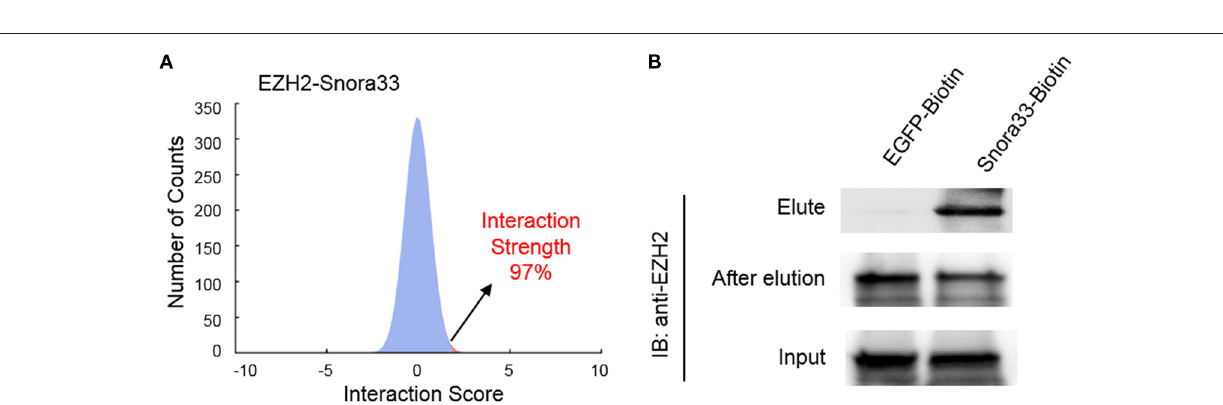
FIGURE 5 | Validation of the interaction between EZH2 and Snora33. (A) Predicted interaction strength between EZH2 and Snora33 using catRAPID. Among a thousand of random RNA sequences, Snora33 ranked 97% propensity to interact with EZH2. (B) RNA pull-down analysis to confirm the direct interaction between Snora33 and EZH2. Biotin was conjugated to the 3 ′ of Snora33 RNA in vitro , followed by streptavidin pull-down assay. Immunoblotting was performed with anti-EZH2 antibody using the elute, flow-through and input